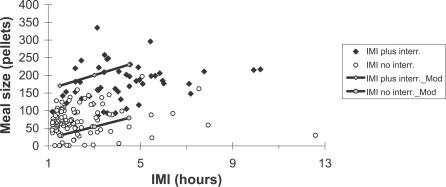
Effect on the Meal Sizes when Previous IMIs of Similar Length Include or Do Not Include Enforced InterruptionsCompares the number of pellets eaten after IMIs with interruptions (filled diamonds) and others (measured in the same way as in Figure 4) without them (empty circles). Solid line shows the linear regression of the simulated data: the IMIs with interruptions (gray diamonds) and without (gray circles).